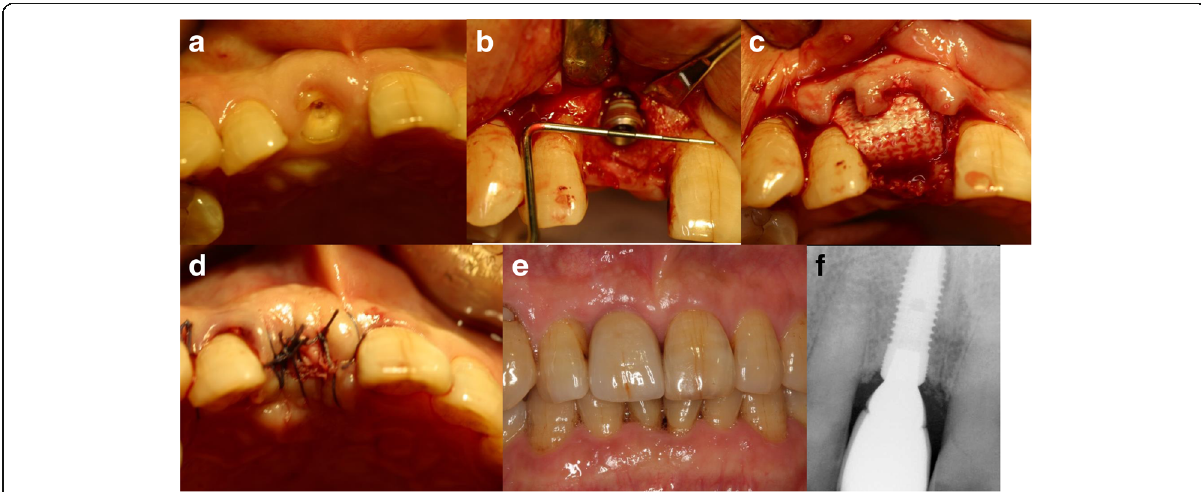
Fig. 3 Socket sealing with a resorbable collagen membrane. a The first visit. b Implant placement. c Bio-Oss was transplanted to the labial dehiscence defect before the collagen membrane (Ossix) was covered and the wound was sutured. d Flap undermining was not performed to promote labial soft tissue contour maintenance, and the membrane where the upper part of implant was covered was intentionally left exposed. e Intraoral view 48 months after final prosthesis placement. f Periapical radiograph 72 months after final prosthesis placement